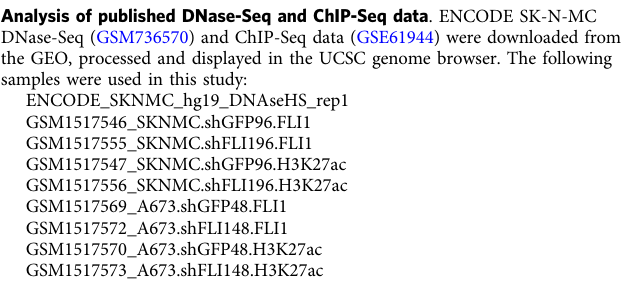
RNA extraction, reverse transcription, and qRT-PCR . Total RNA was isolated using the NucleoSpin RNA kit (Macherey-Nagel, Germany). 1µg of total RNA was reverse-transcribed using High-Capacity cDNA Reverse Transcription Kit (Applied Biosystems, USA). qRT-PCR reactions were performed using SYBR green Mas- termix (Applied Biosystems) mixed with diluted cDNA (1:10) and 0.5µM forward and reverse primer (total reaction volume 15µl) on a BioRad CFX Connect instrument and analyzed using BioRad CFX Manager 3.1 software. Gene expres- sion values were calculated using the 2 − ( ΔΔ Ct) method 56 relative to the house- keeping gene RPLP0 as internal control. Oligonucleotides were purchased from MWG Euro fi ns Genomics (Germany) and are listed in Supplementary Table 2. The thermal conditions for qRT-PCR were as follows: heat activation at 95 °C for 2 min, DNA denaturation at 95 °C for 10 s, and annealing and elongation at 60°C for 20s (50 cycles), fi nal denaturation at 95°C for 30 s.